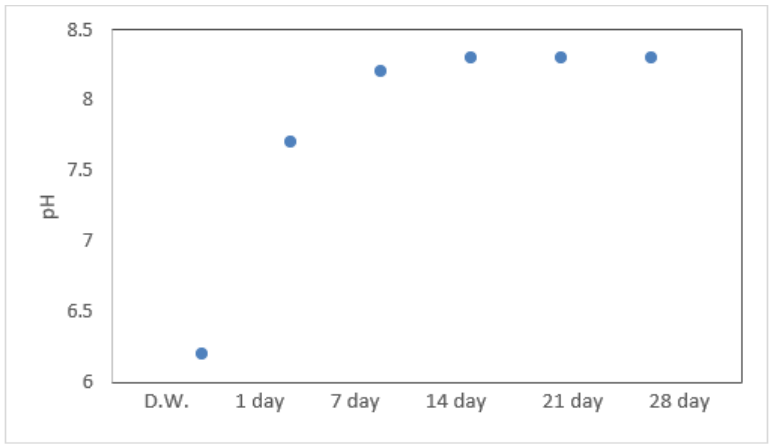
Figure 2. Leaching variation over 28